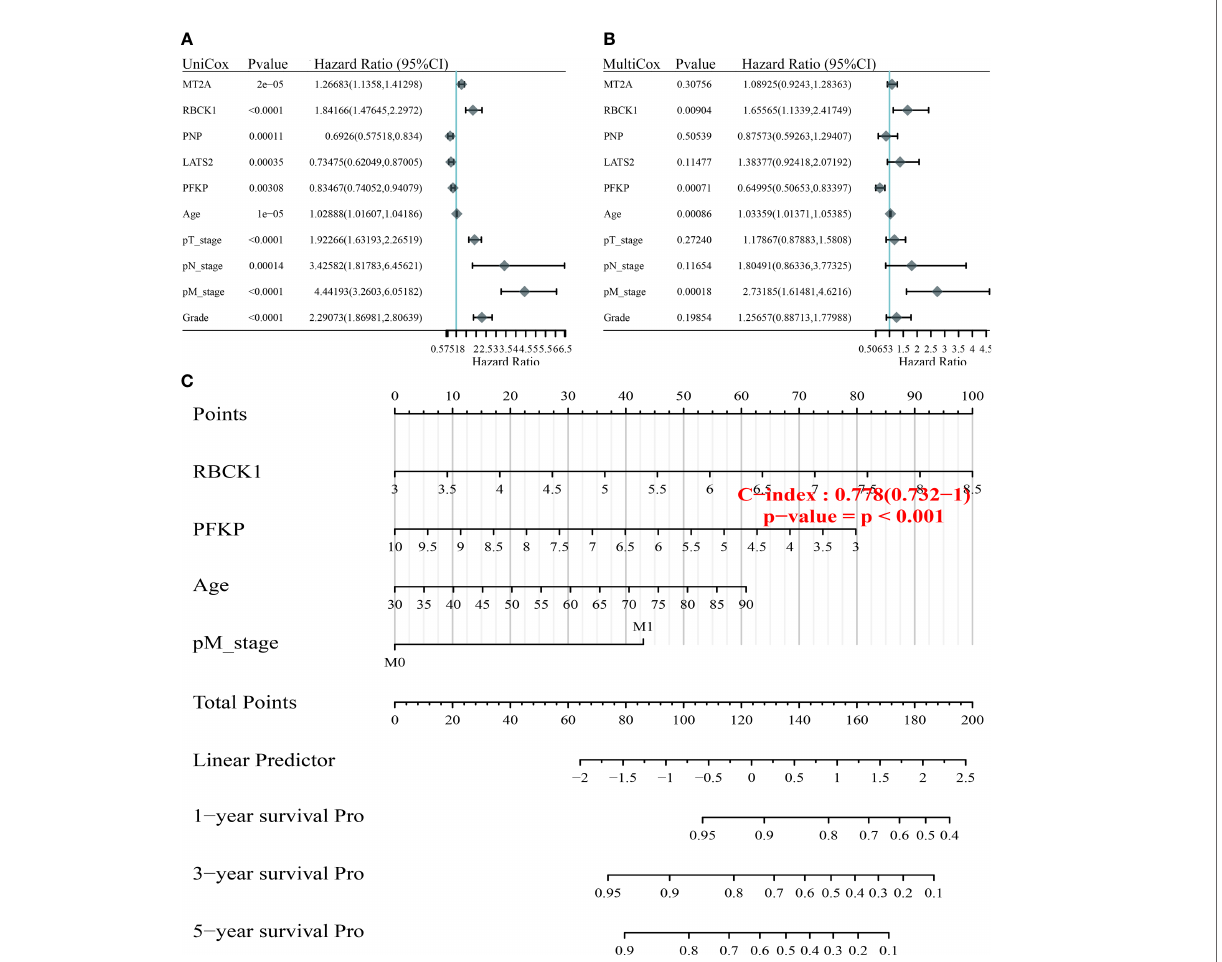
FIGURE 6 | Construction of the nomogram predicting the prognosis of ccRCC. (A, B) Hazard ratio and p ‐ value of constituents involved in univariate and multivariate Cox regression enrolling clinicopathological features and fi ve IFN- g response signatures with the most prognostic signi fi cance. (C) The nomogram provided a graphical representation of the clinicopathological features and IFN- g response signatures, which can be used to calculate the risk of recurrence for an individual patient by the points associated with each risk factor through the “ rms ” R